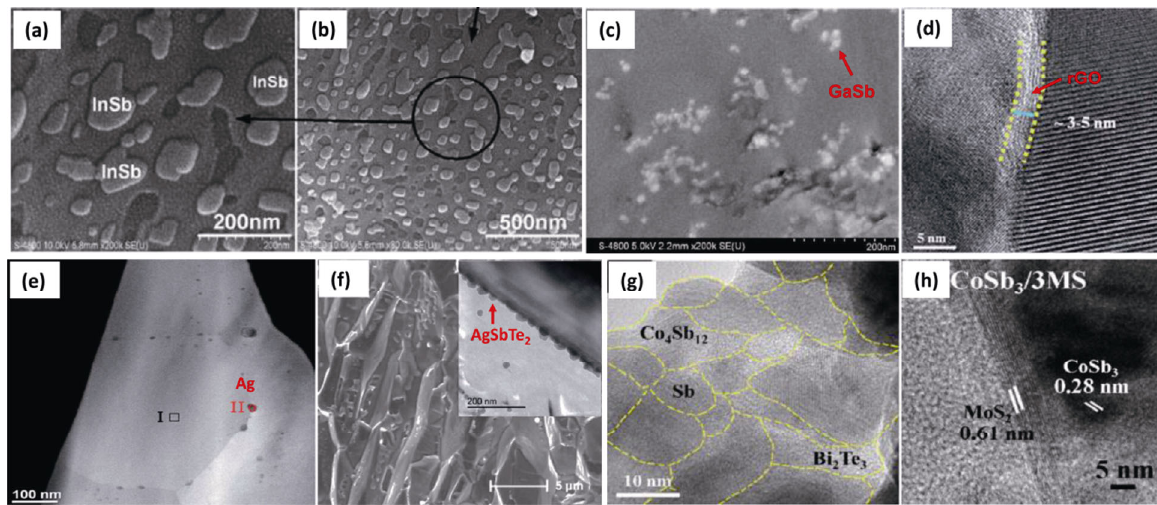
Fig. 10 Microstructure of CoSb 3 -based nanocomposite TE materials. (a, b) FESEM photographs of In x Ce y Co 4 Sb 12 nanocomposite materials with in situ forming nanostructured InSb phase. Reproduced with permission from Ref. [78], © American Institute of Physics 2009. (c) FESEM photograph of Yb 0.26 Co 4 Sb 12 /0.2GaSb nanocomposite material. Reproduced with permission from Ref. [169], © Acta Materialia Inc. 2010. (d) HETEM photograph of Yb y Co 4 Sb 12 /rGO nanocomposite material. Reproduced with permission from Ref. [170], © The Royal Society of Chemistry 2015. (e) TEM photograph of Ag/Ba 0.3 Co 4 Sb 12 nanocomposite material. Reproduced with permission from Ref. [179], © The Royal Society of Chemistry 2012. (f) FESEM and TEM photographs of AgSbTe 2 /Yb 0.2 Co 4 Sb 12 nanocomposite material. Reproduced with permission from Ref. [183], © The Royal Society of Chemistry 2015. (g) TEM photograph of Bi 2 Te 3 /CoSb 3 nanocomposite material. Reproduced with permission from Ref. [189], © IOP Publishing Ltd. 2018. (h) TEM photograph of MoS 2 /CoSb 3 nanocomposite material. Reproduced with permission from Ref. [190], © Elsevier B.V. 2017.